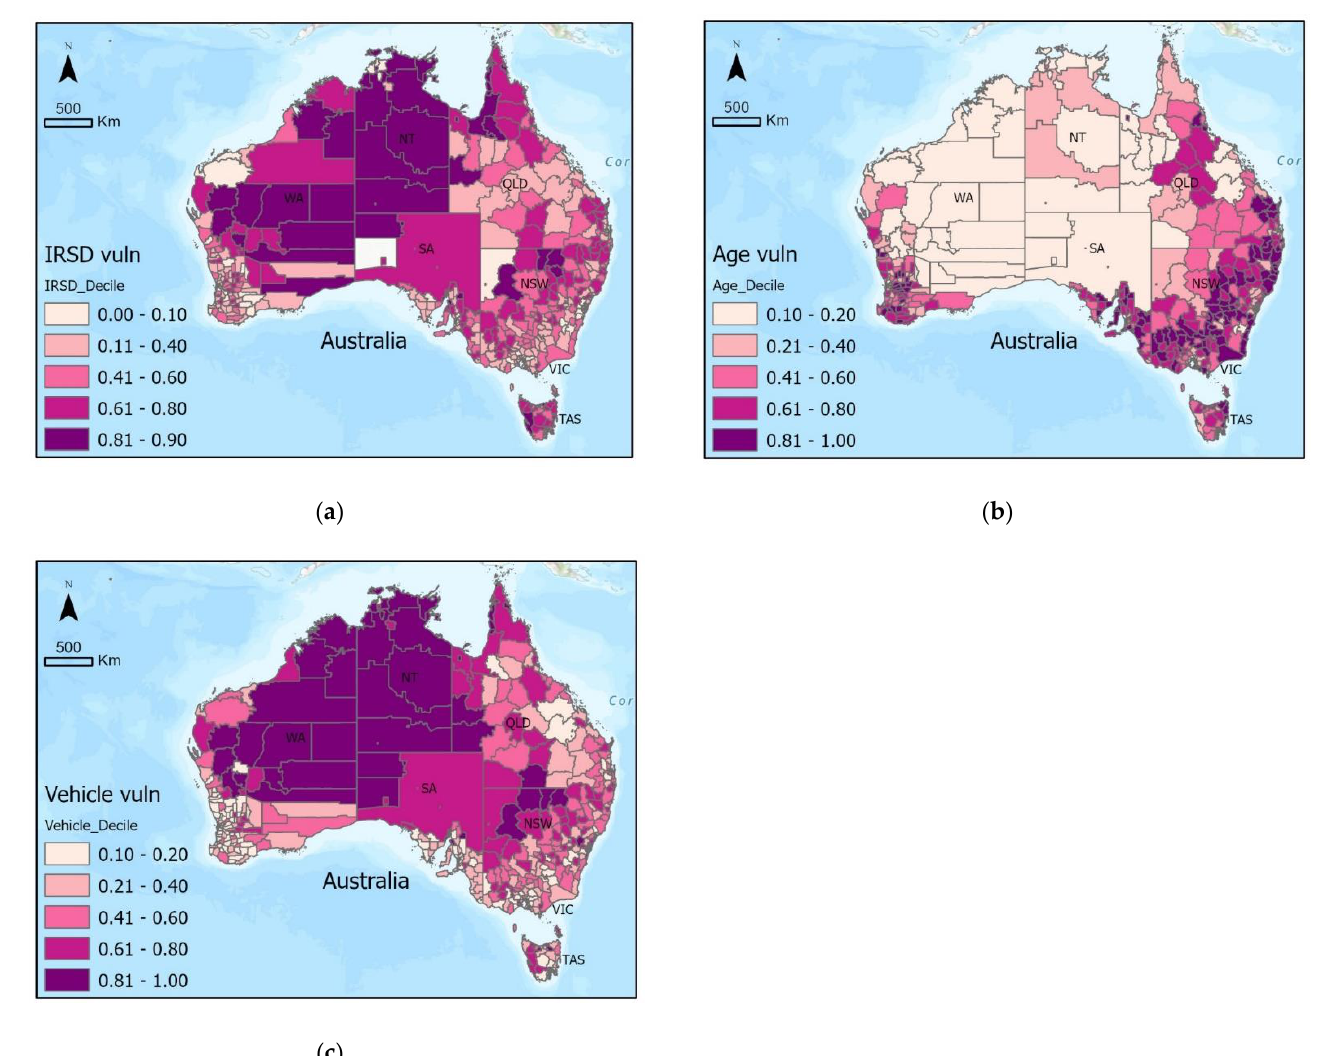
Figure 8. Vulnerability indicator maps of IRSD (a), vulnerable age groups (b), and no-vehicle homes (c).